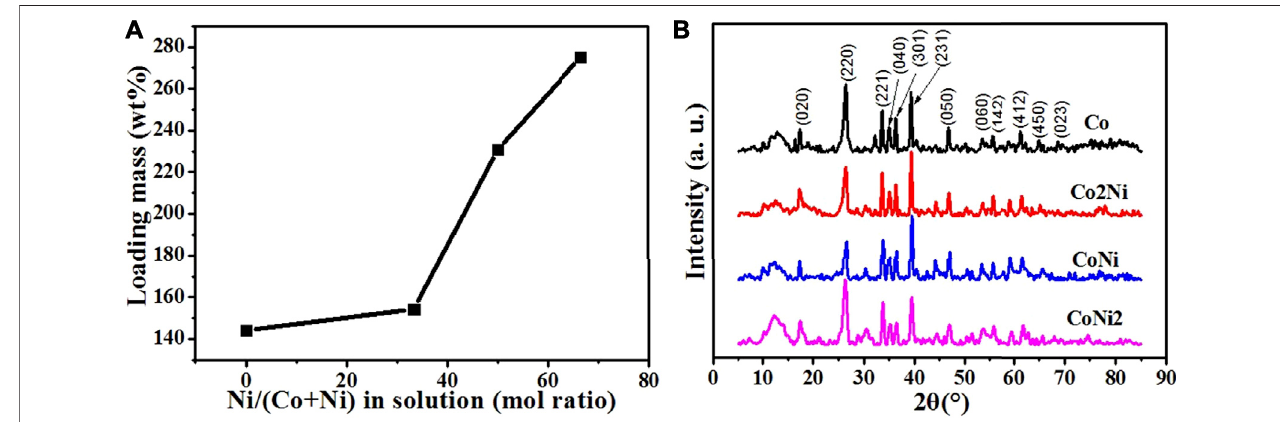
FIGURE 1 | (A) The loading mass of Co basic carbonates with different Ni doping degrees. (B) XRD patterns of pristine Co/Ni basic carbonate/CNT network.